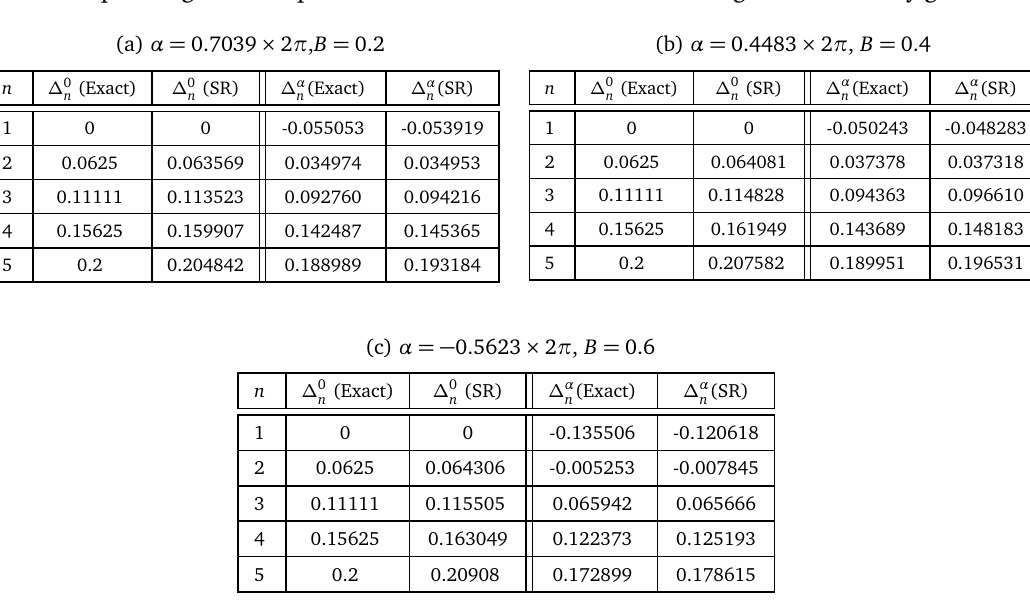
Table 1: The ∆ -sum rule in the two-particle approximation (SR) compared with the exact conformal dimension of the exponential CFT in the shG model (61) for various values of α and B . These include α = 0, that is the standard BPTF and n = 1, α (cid:54) = 0 corresponding to the exponential field in shG. In all cases the agreement is very